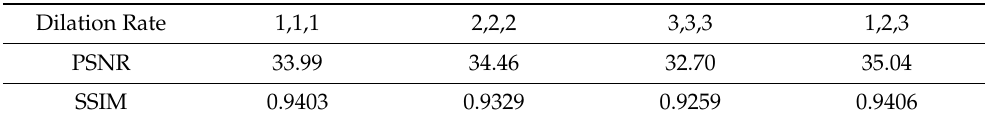
Table 4. Average PSNR and SSIM of proposed MARCAFNet when using CS blocks with various dilation rates in two synthetic datasets (Rain100H and Rain